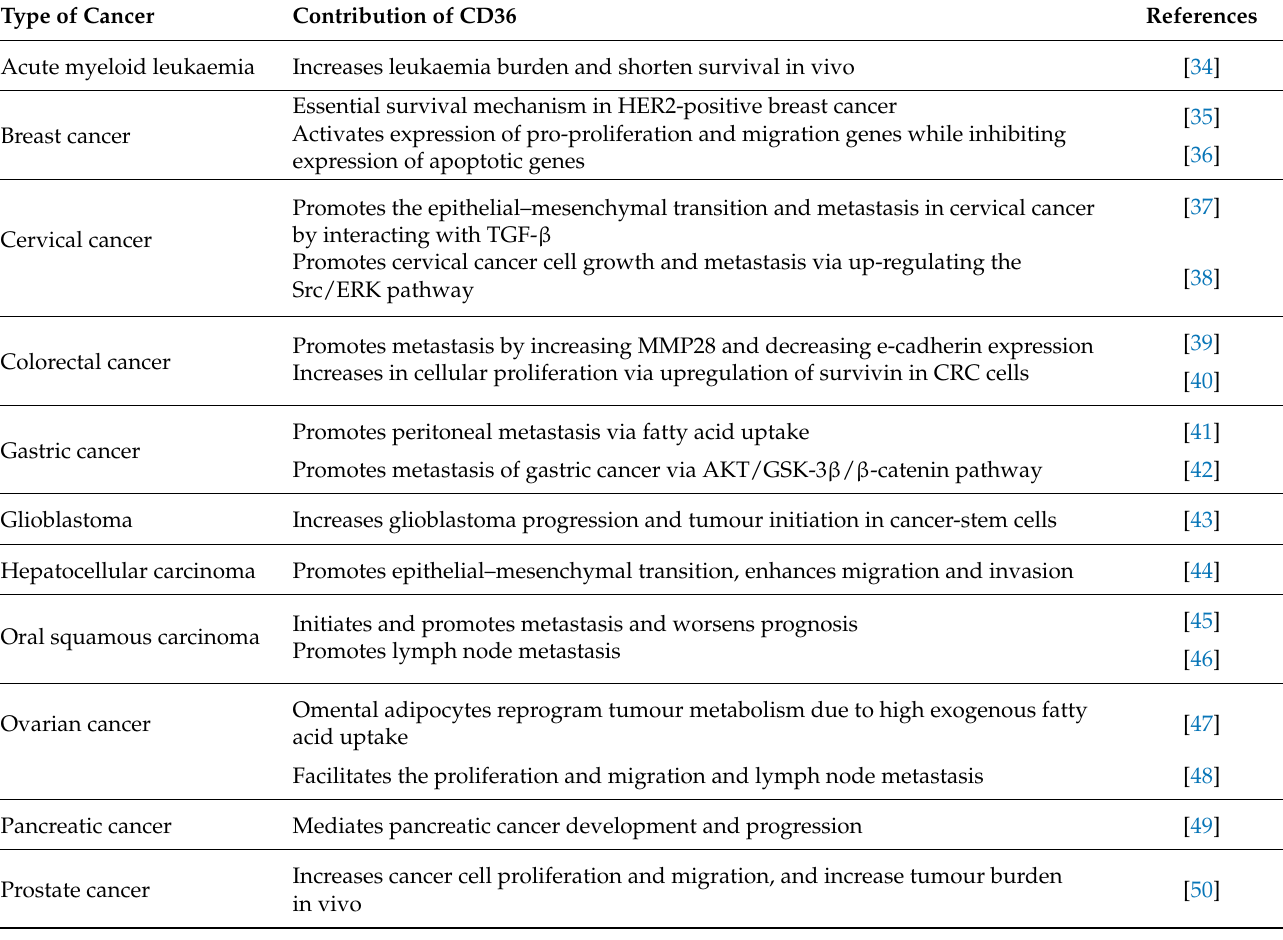
Table 1. Contributions of CD36 expression in various type of cancer